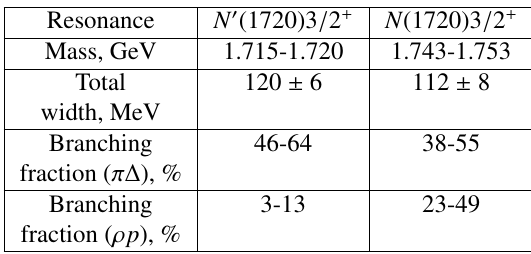
Table 4. Masses and the total and partial hadronic decay widths to the π ∆ and ρ p final hadron states of the convention N (1720)3 / 2 + and candidate N (cid:48) (1720)3 / 2 + resonances obtained from the CLAS π + π − p data [17, 23] fit within the JM